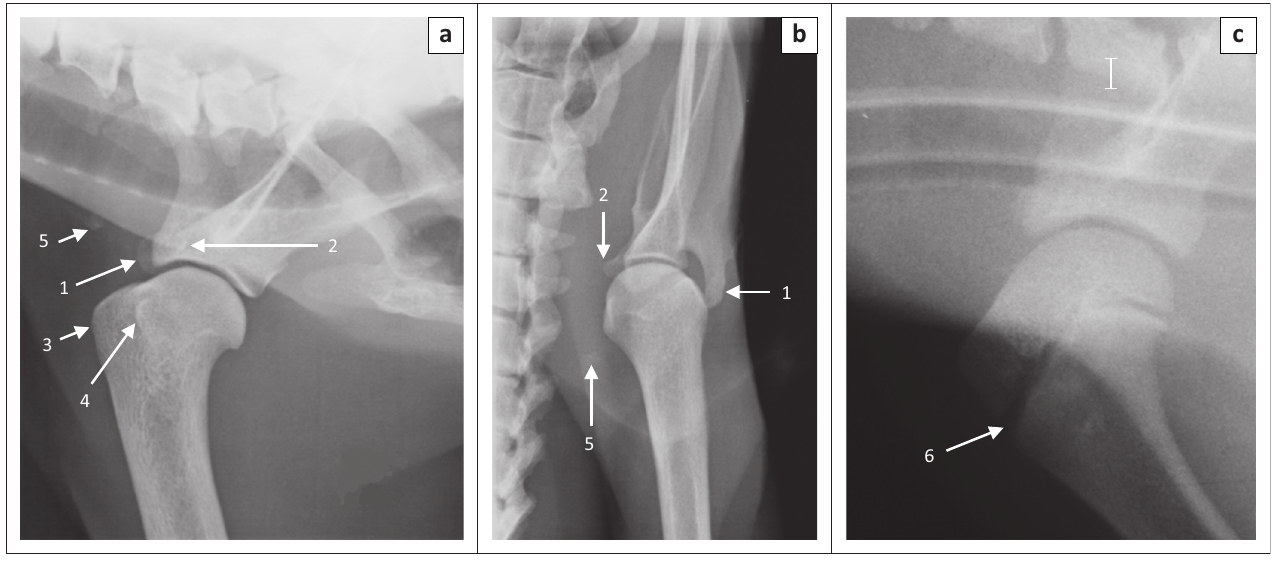
FIGURE 1: Radiographs of the right shoulder joints of (a, b) a 14.3-year-old male and (c) a skeletally immature red panda. Mediolateral views are shown in (a) and (c) and a caudocranial view in